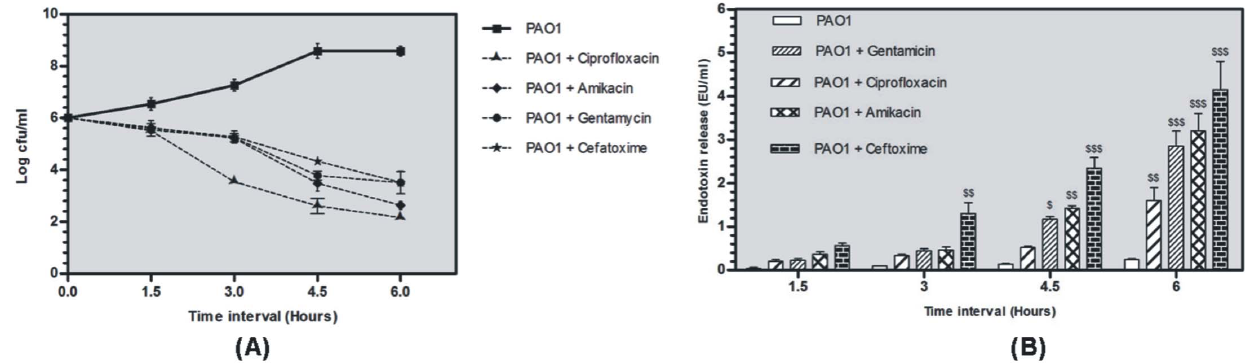
Figure 1. Invitro bacterial killing (Fig.1-A) and endotoxin release (Fig.1-B) potential of antibiotics against P.aeruginosa PAO1 ( $ p , 0.01, $$ p , 0.01 and $$$ p , 0.001).